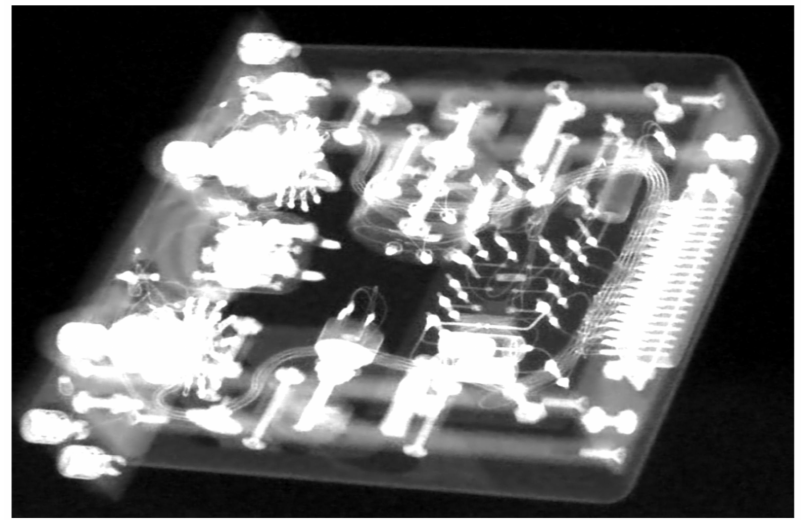
Figure 11. Result of the denoising of KH-09-09 using the CNN of Figure